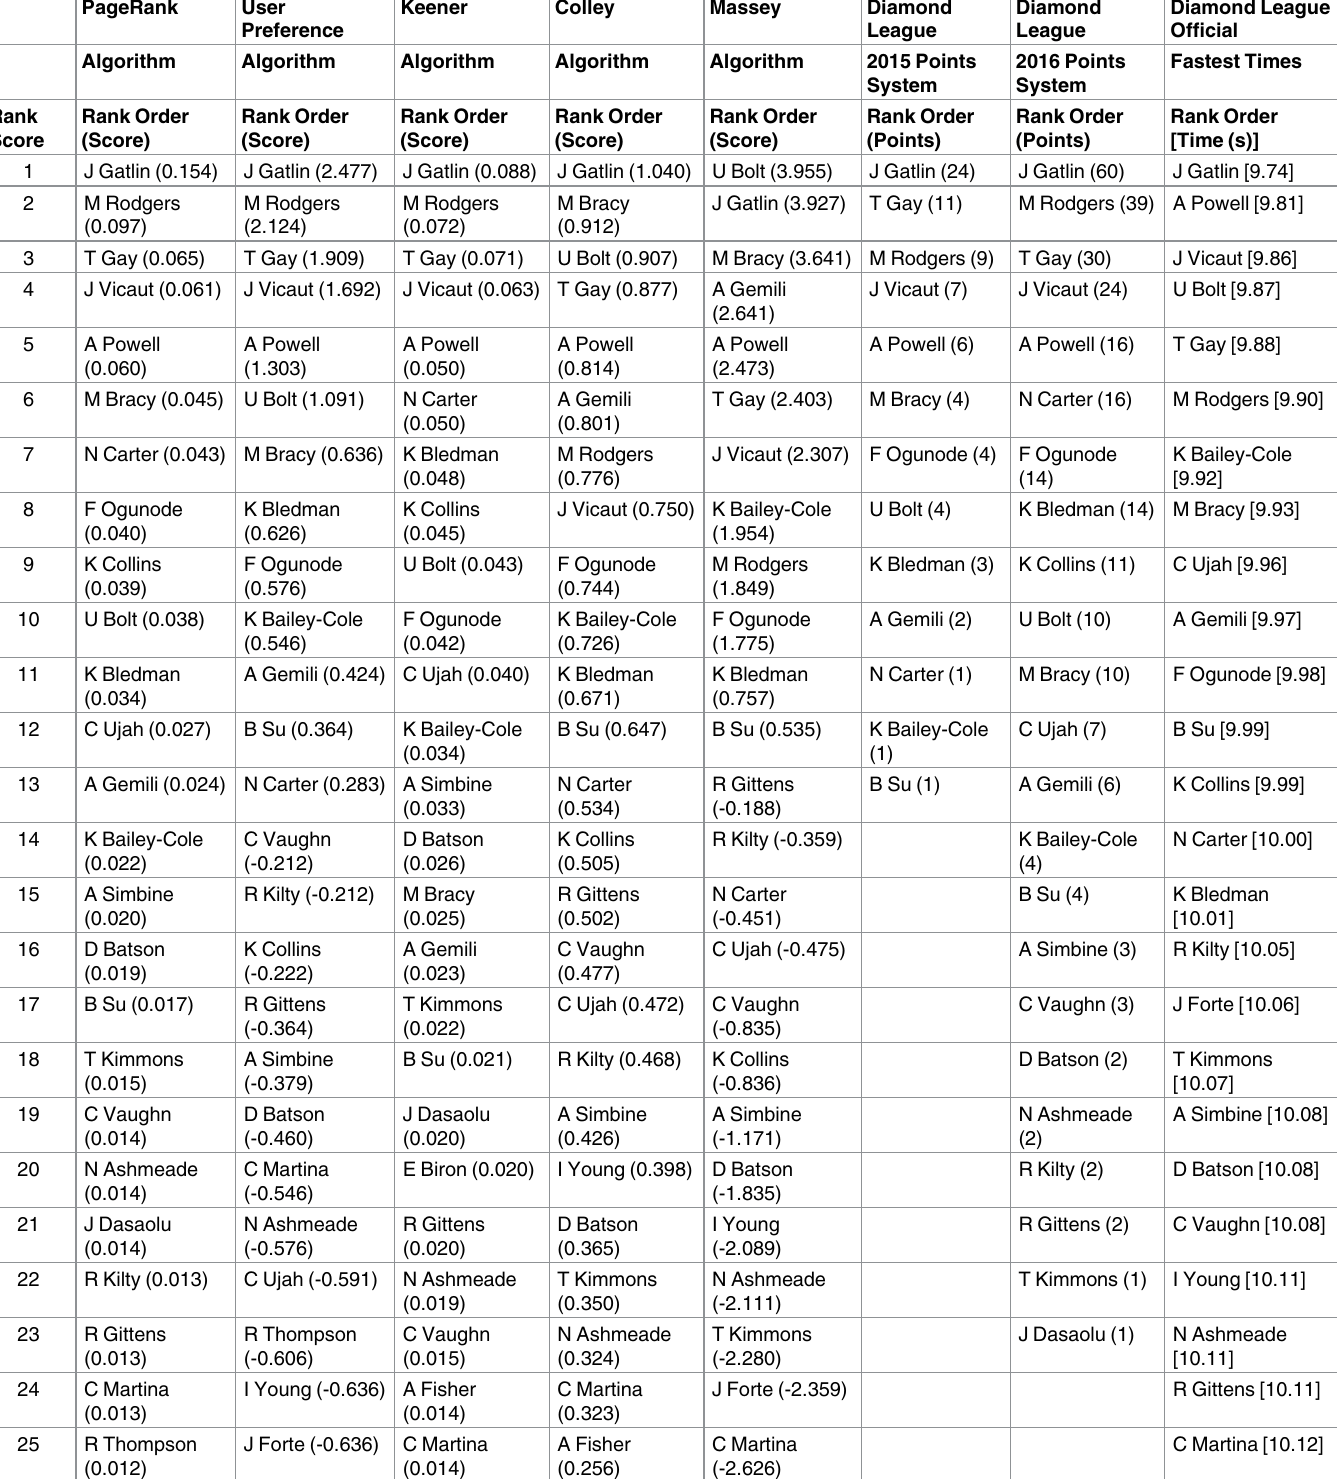
Table 4. Final standings computed using the various ranking algorithms together with the standings computed using methods adopted by the Diamond League. PageRank User Keener Colley Massey Diamond Preference